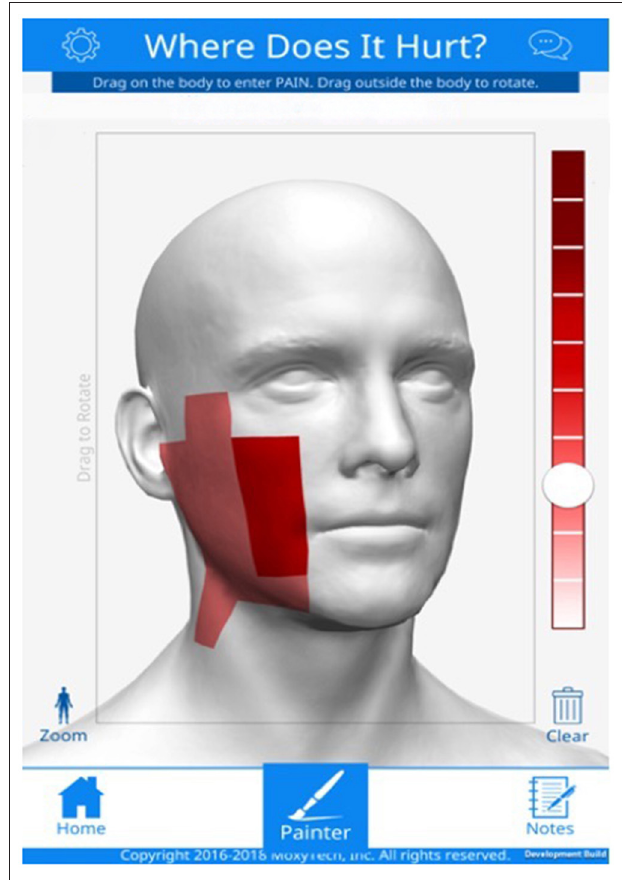
FIGURE 3 | Geo-pain software graphical user interface, MoxyTech Inc,